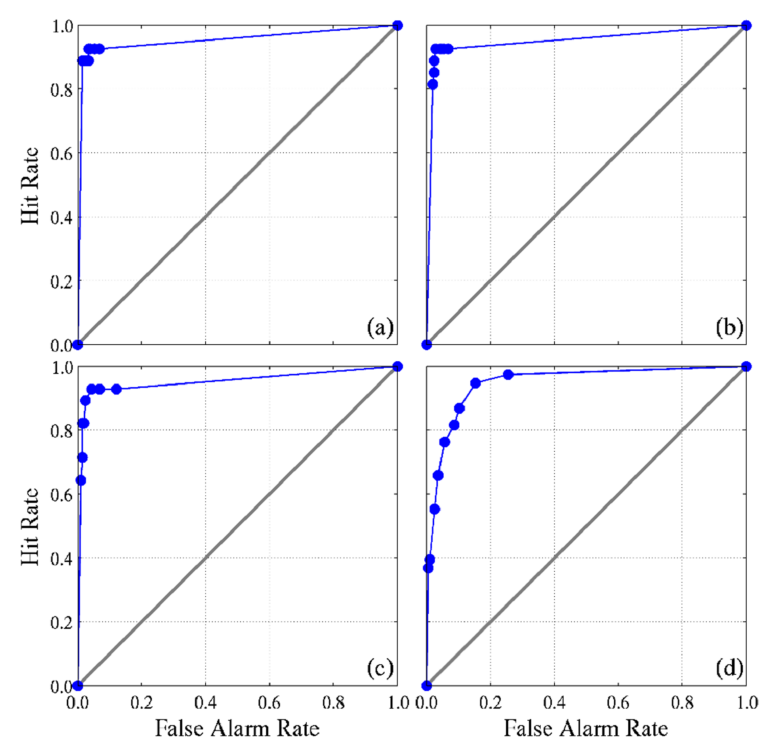
Figure 10. ROC with significant wave height of 2 m or above with forecasting lead times of ( a ) +00 h, ( b ) +24 h, ( c ) +48 h, and ( d ) +72